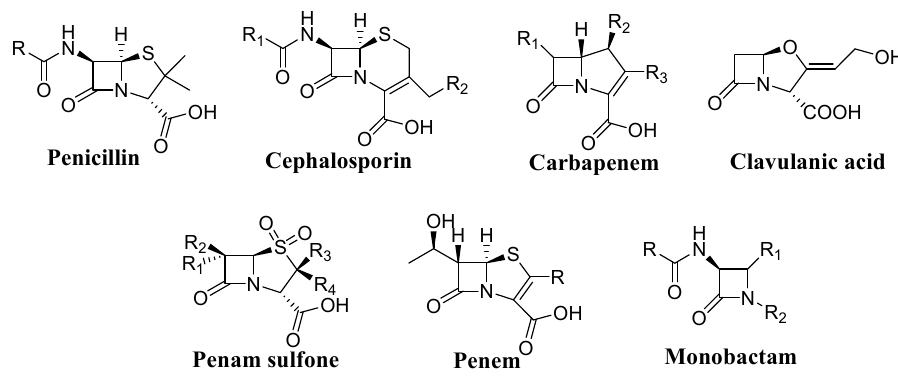
Figure 1. Representative β -lactam structures.